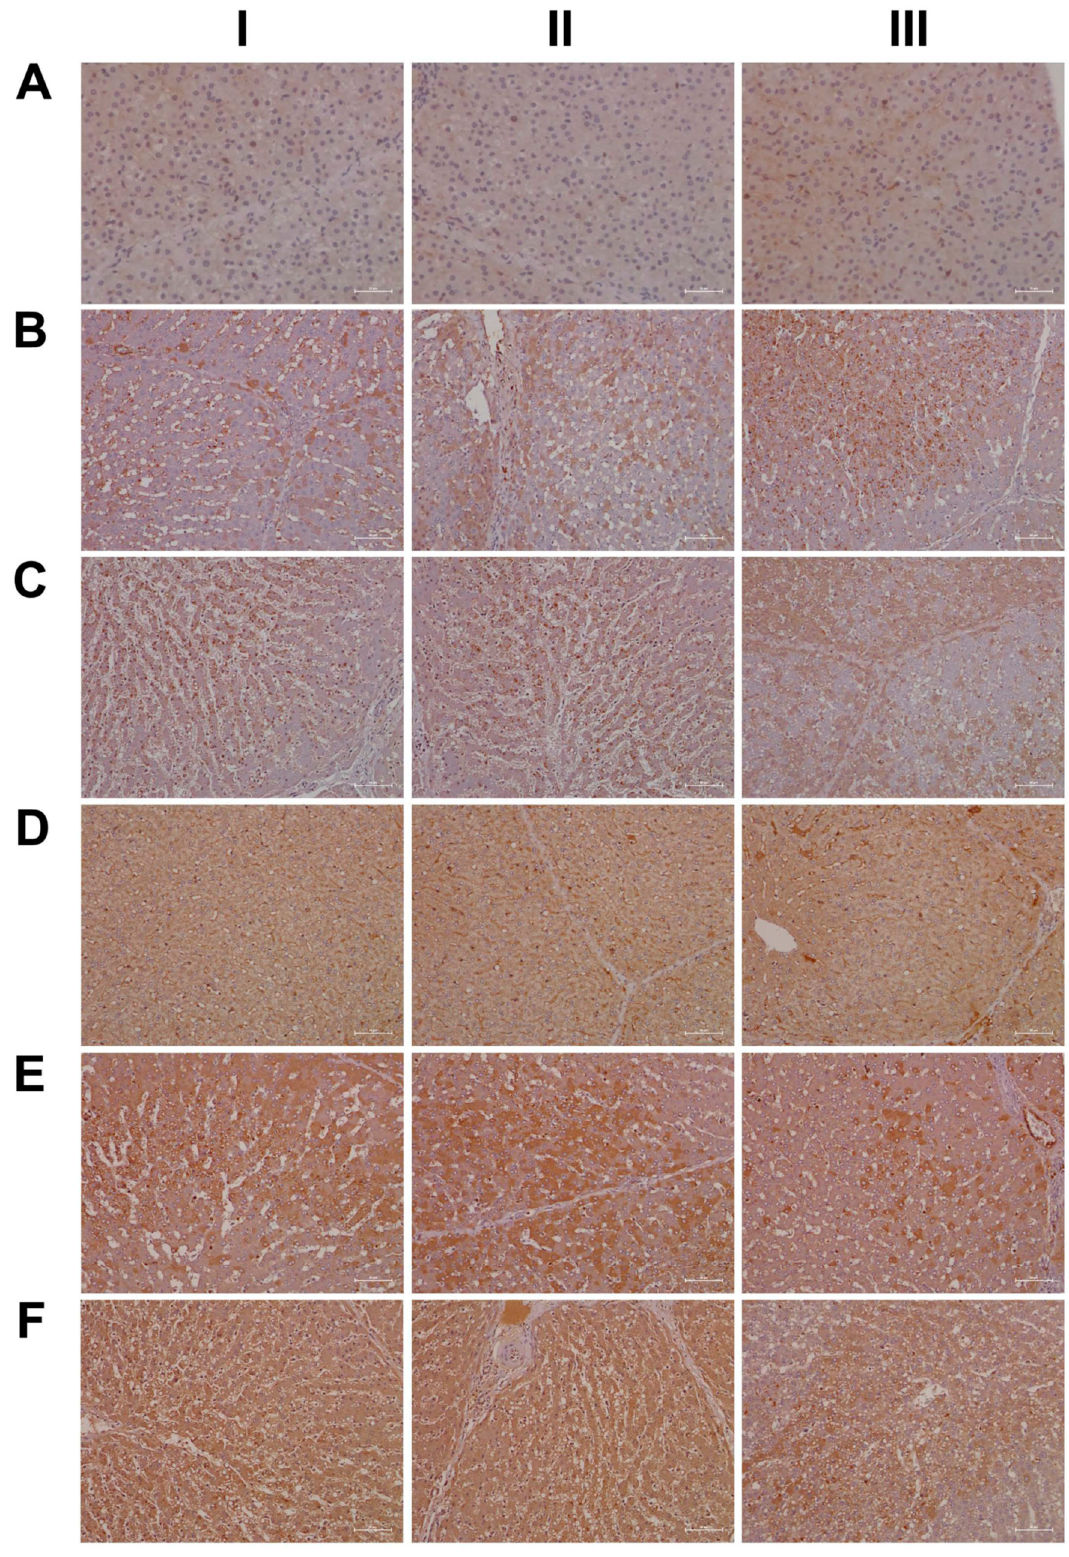
Figure 16. Immunohistochemistry of the liver clock components CLOCK and CYP1A1 in liver sections of control and diclofenac-treated animals after daily dosing for 28 days. CLOCK is a transcription factor and, together with BMAL1, forms a heterodimer and binds to E-Box in the promoter of Per1/2 and Cry1/2 to augment their expression. Furthermore, the aryl hydrocarbon receptor (AhR)